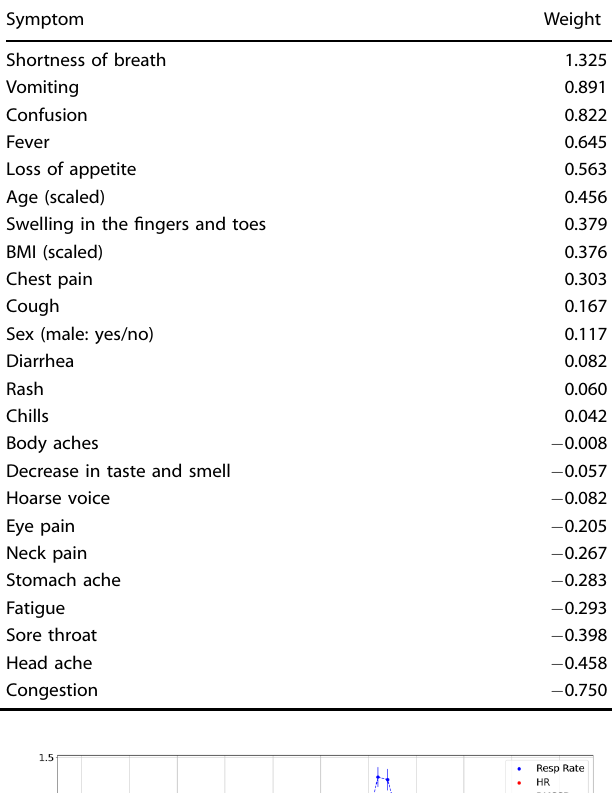
Table 1. Predicting the need for hospitalization: importance of symptoms.